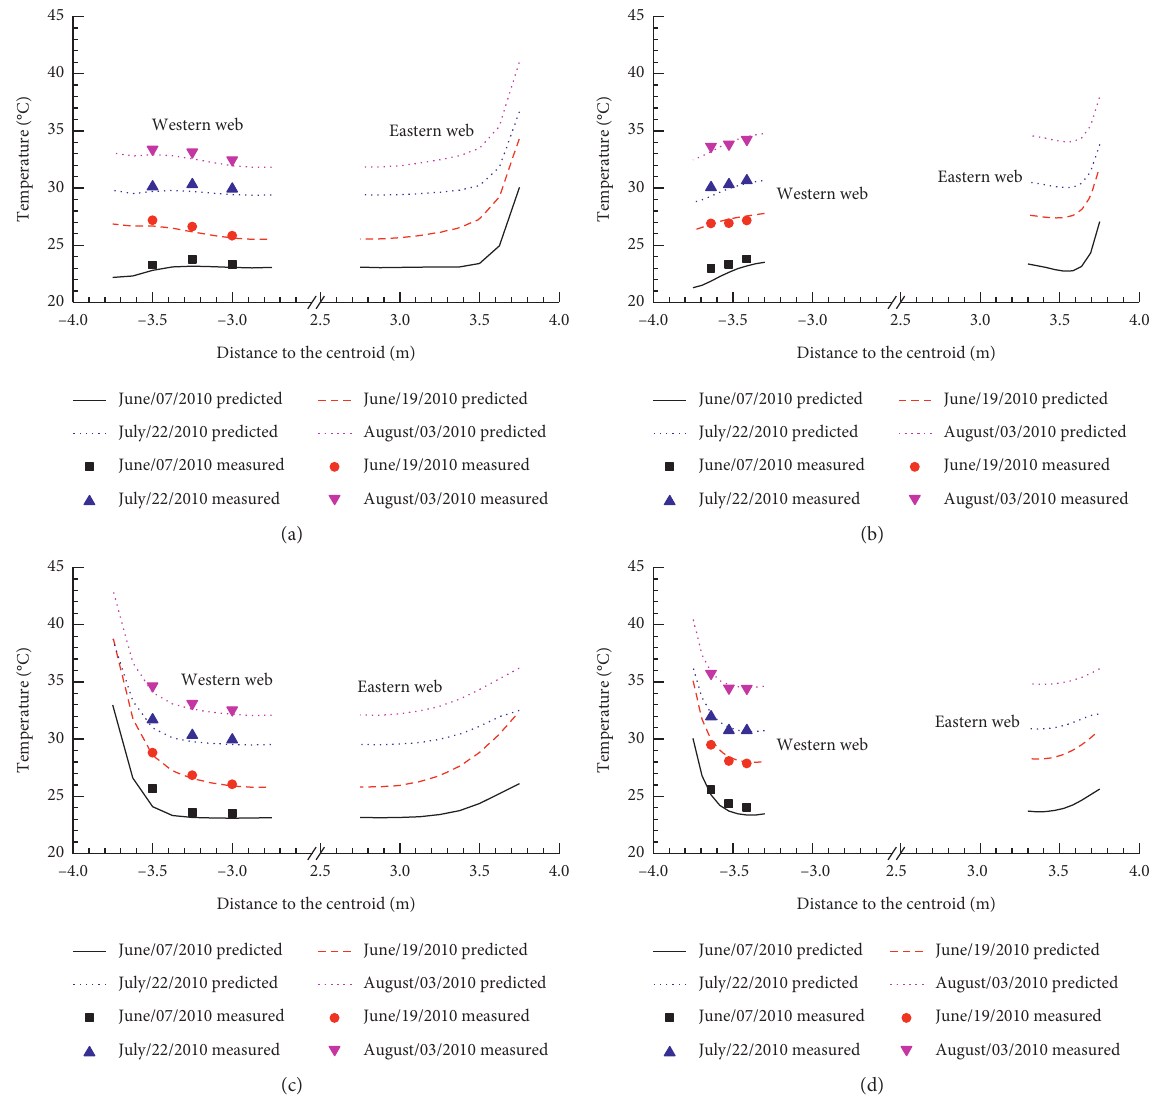
Figure 13: The predicted transverse temperature distributions along the web of the girder for the four sunny days: (a) section T1 and the temperature on the outer surface of the eastern web reached a maximum value; (b) section T2 and the temperature on the outer surface of the eastern web reached a maximum value; (c) section T1 and the temperature on the outer surface of the western web reached a maximum value; (d) section T2 and the temperature on the outer surface of the western web reached a maximum